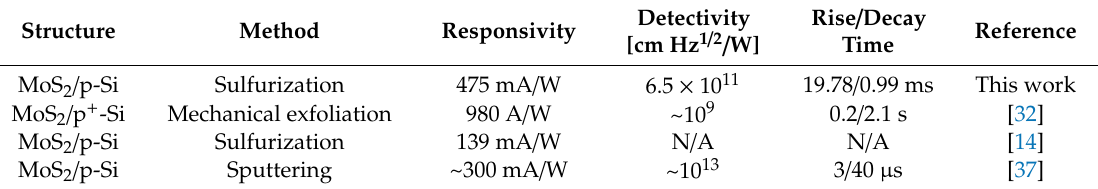
Table 1. Comparison of MoS 2 and Si based photodetectors.